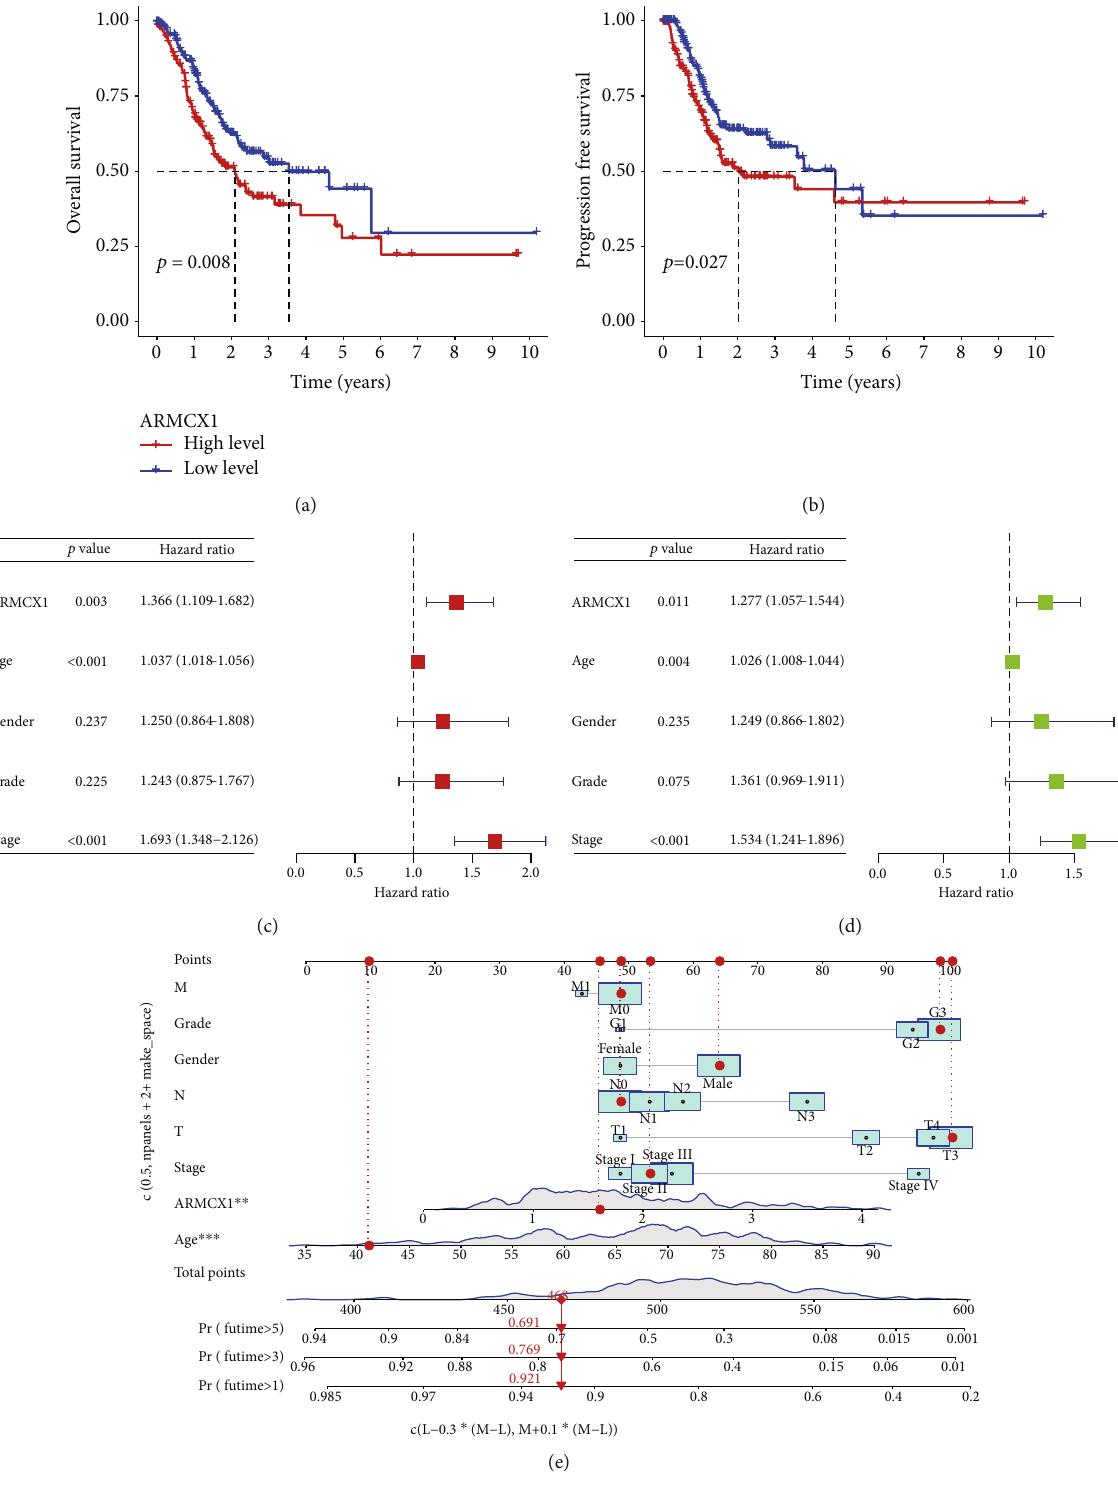
Figure 2: ARMCX1 expression could potentially serve as a prognostic marker. (a) Correlation between ARMCX1 expression and overall survival (OS). (b) Correlation between ARMCX1 expression and PFS. (c) Multivariate analysis of overall survival. (d) Univariate analysis of overall survival. (e) The total nomogram point of each patient can be used to predict the probability of survival at 1, 3, and 5